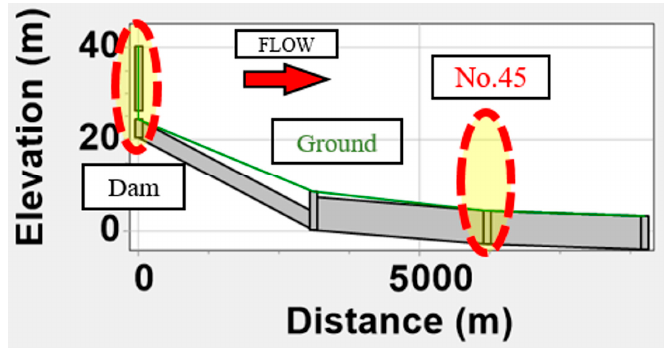
Figure 3. Longitudinal section of the Suyeong River area (partial).